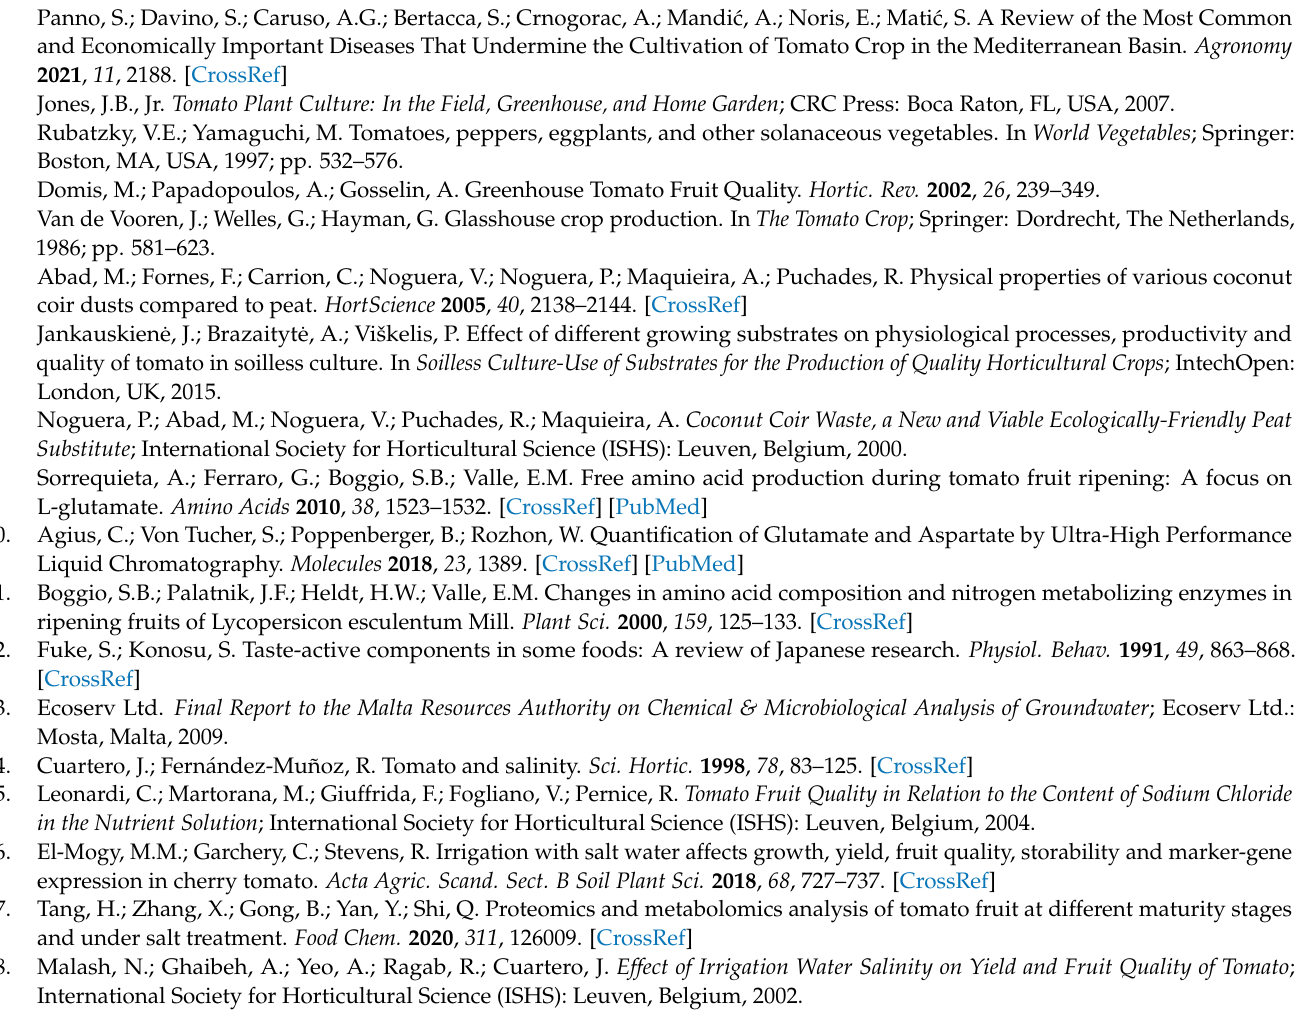
preparation of the stock solutions, Table S4: Amount of salts required for preparation of one litre of a 100-fold stock solution, Table S5: Contents of amino acids in fruits, Supplementary File S1: Raw